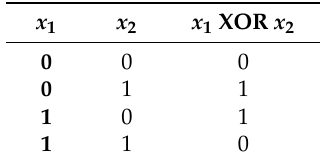
Table 1. Truth table of the logical operator